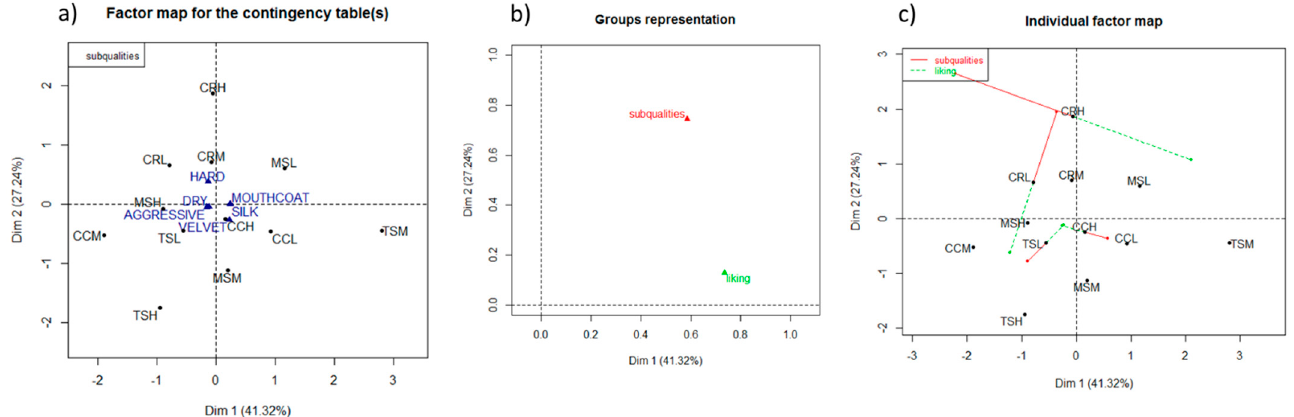
Figure 3. Preference map by the Multiple Factor Analysis ( a ), factor map for contingency table; ( b ), groups representation; ( c ), individual factor map on the consumers’ liking scores as a supplementary variable and CATA frequencies (from consumers) of astringency subqualities for Sangiovese wines (MS: Morellino di Scansano; TS: Toscana; CC: Chianti Classico; CR: Chianti Riserva) belonging to low (–L), medium (–M), and high (–H) price range.